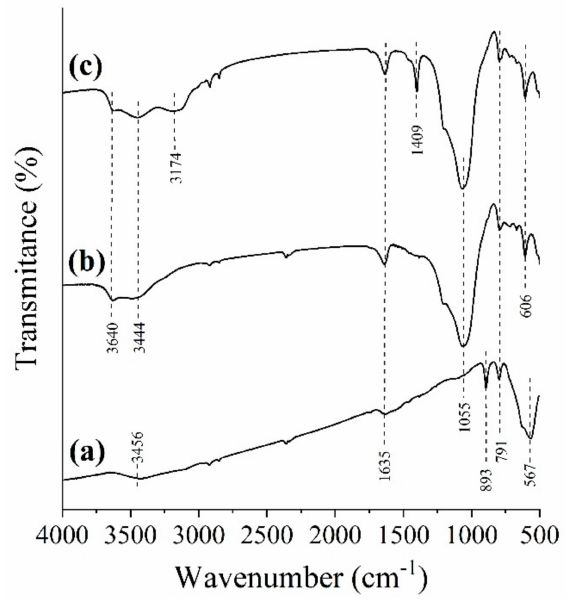
Figure 5. FTIR spectra of MAG ( a ), CLI ( b ) and MAG-CLI ( c ).